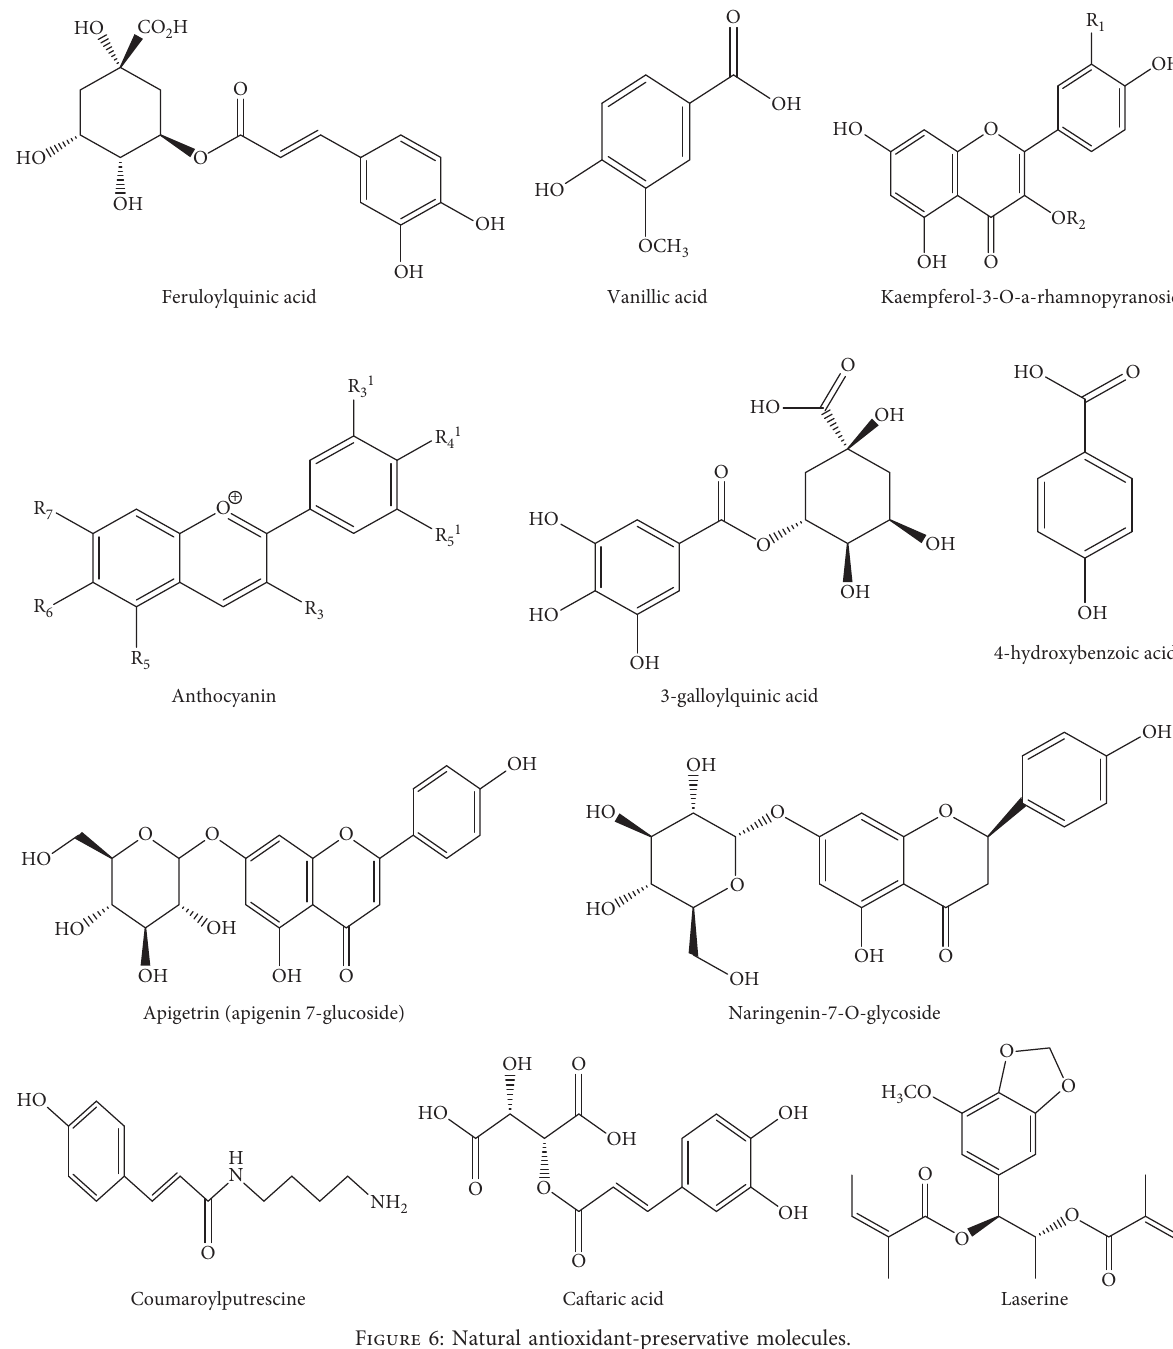
Figure 6: Natural antioxidant-preservative